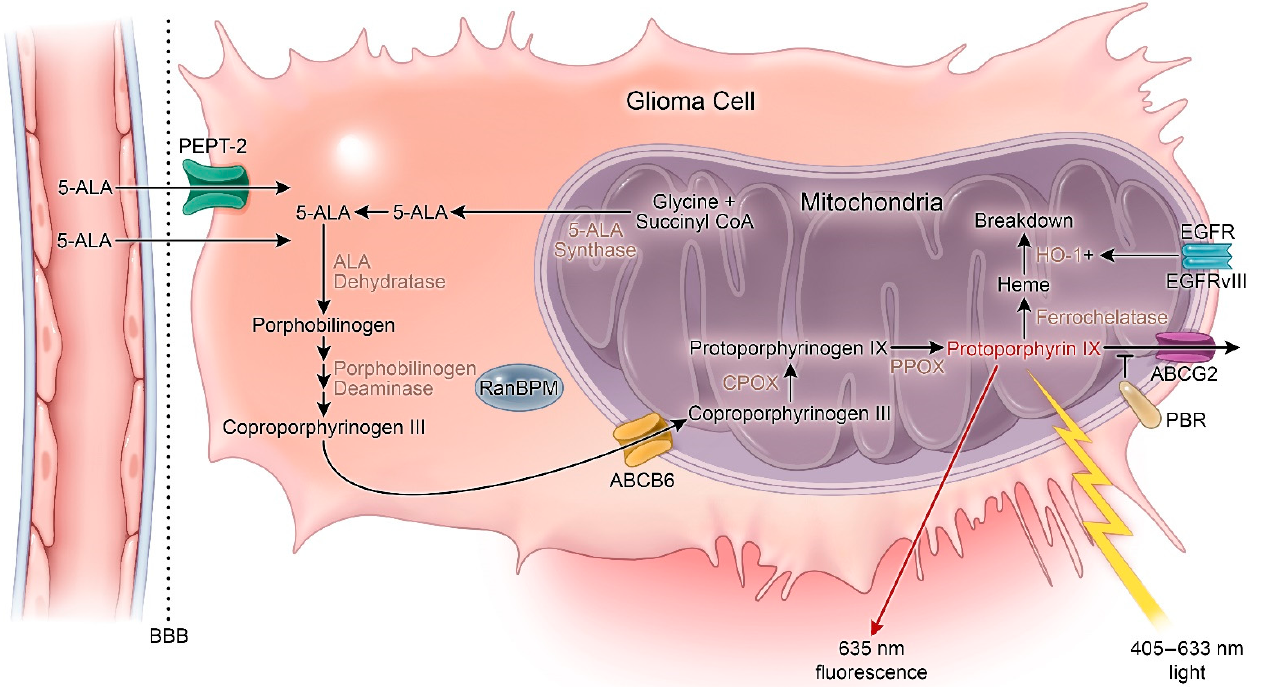
Figure 1. Heme synthesis pathway and mechanism of 5-aminolevulinic acid (5-ALA) fluorescence. 5-ALA: 5-aminolevulinic acid; ABCG2: ATP-binding cassette G2; ABCB6: ATP-binding cassette B6; BBB: Blood–brain barrier; CPOX: Coproporphyrinogen oxidase; HO-1: Heme-oxygenase 1; PBR: Peripheral benzodiazepine receptor; PPOX: Protoporphyrinogen oxidase. + = increased activity.